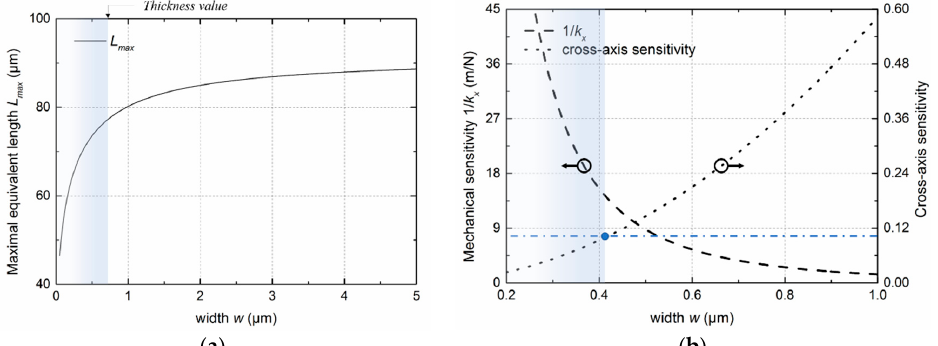
Figure 11. ( a ) Maximal equivalent length of anti-stiction condition as a function of the width; ( b ) mechanical sensitivity and cross-axis sensitivity derived from the maximal equivalent length as a function of the width.